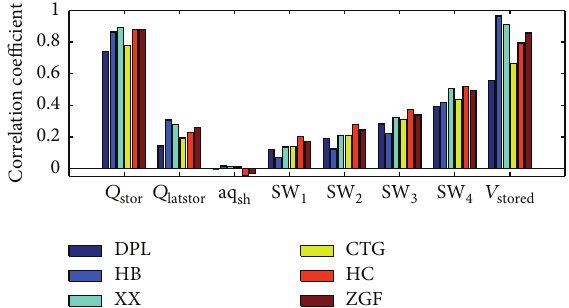
Figure 2: Correlation between the state variables of the fifteenth calculation units and the sixth subbasin on the horizontal axis and the simulated streamflow at six streamflow gauges (DPL, HB, XX, CTG, HC, and ZGF in Figure